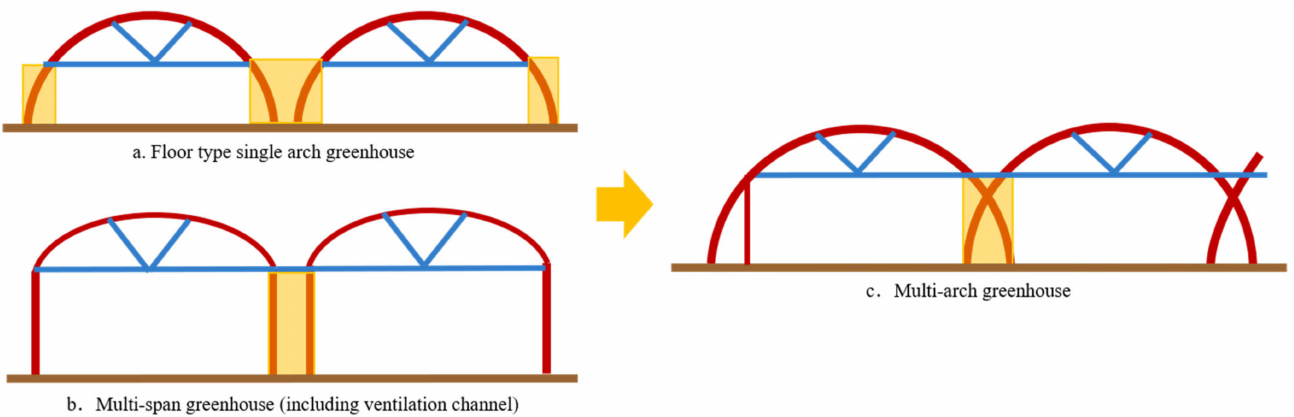
Figure 3. Development idea of a crossed multi-arch